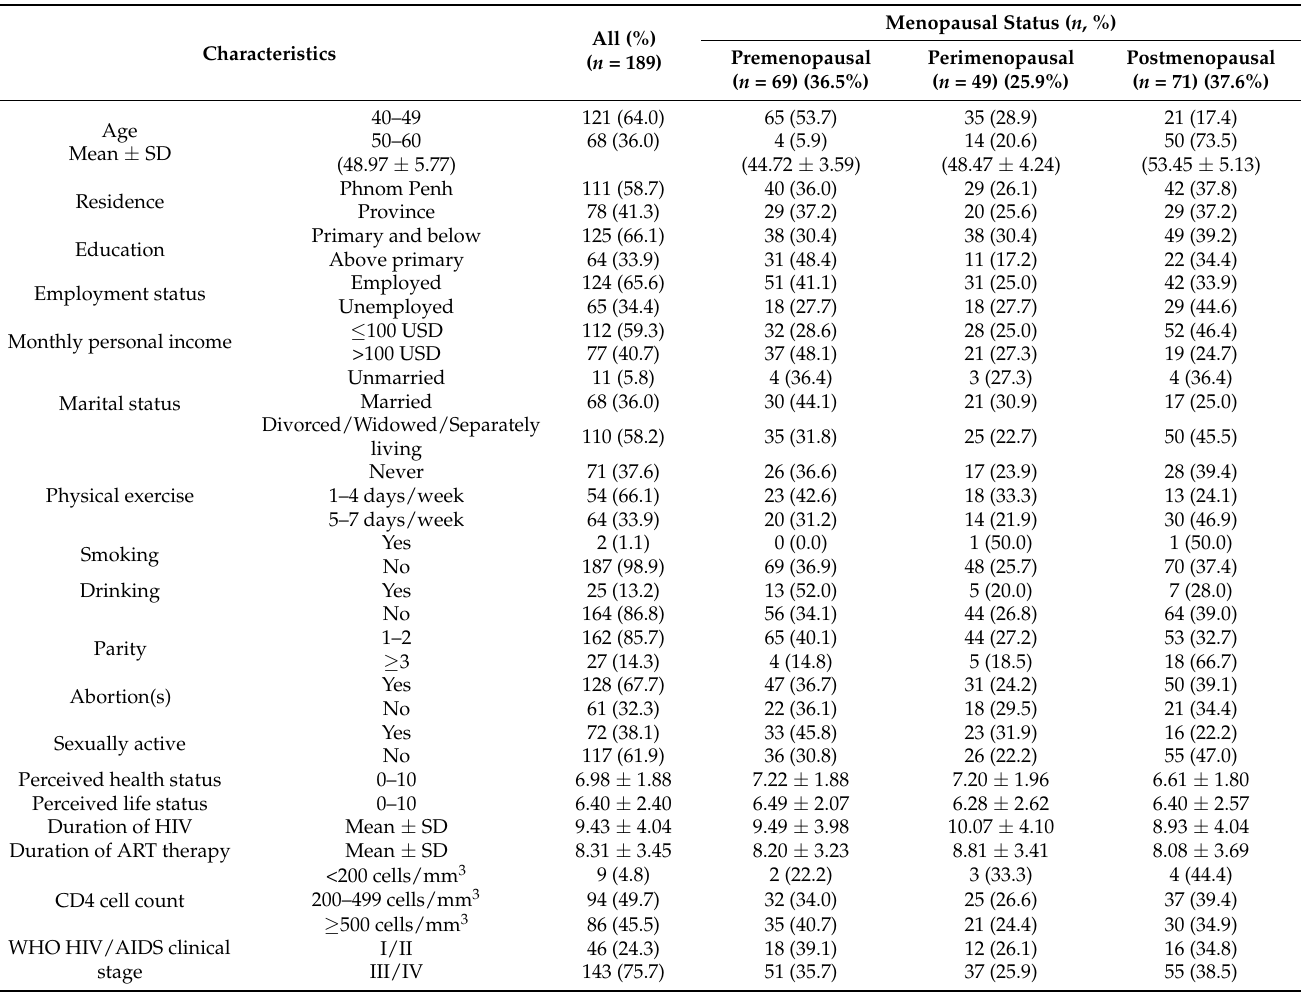
Table 1. Demographic characteristics by menopausal status ( n =